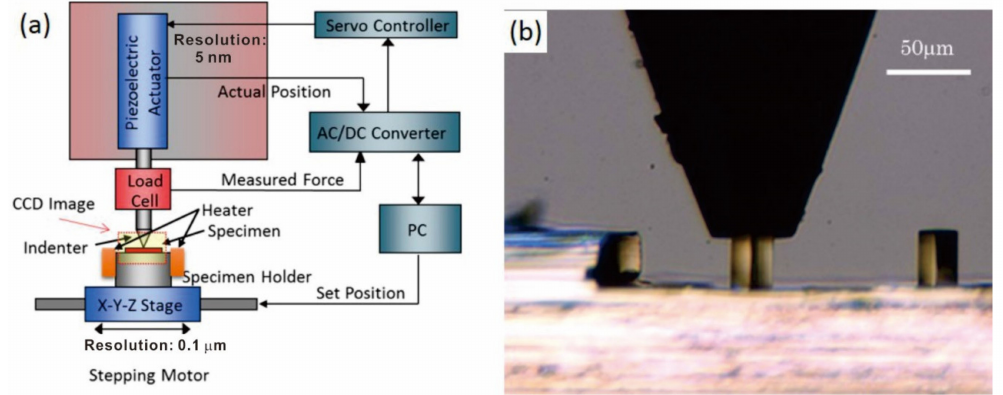
Figure 1. ( a ) Schematic illustration of the temperature-variable micro-compression setup and ( b ) image captured with a charge-coupled device (CCD) camera during in situ compression.